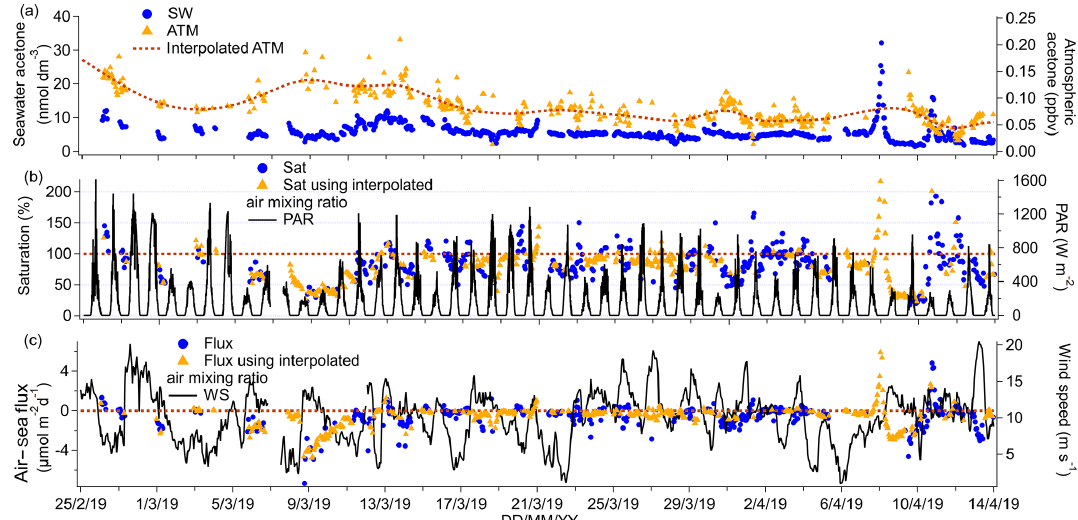
Figure 7. (a) Time series of acetone seawater (SW) concentrations as well as measured and interpolated marine boundary layer air mixing ratios (ATM and interpolated ATM). (b) Time series of acetone saturations determined using the measured air mixing ratio and interpolated air mixing ratio and time series of chlorophyll a . (c) Time series of air–sea acetone fluxes calculated using the measured air mixing ratio and interpolated air mixing ratio and time series of wind